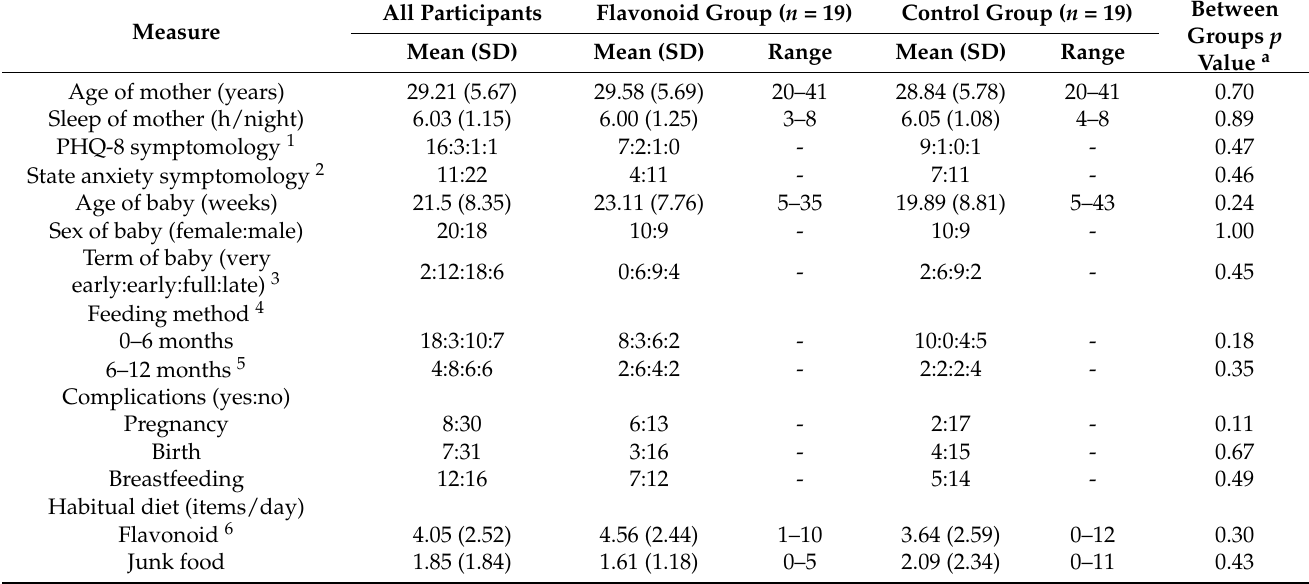
Table 1. Demographic data for mothers and babies in flavonoid and control